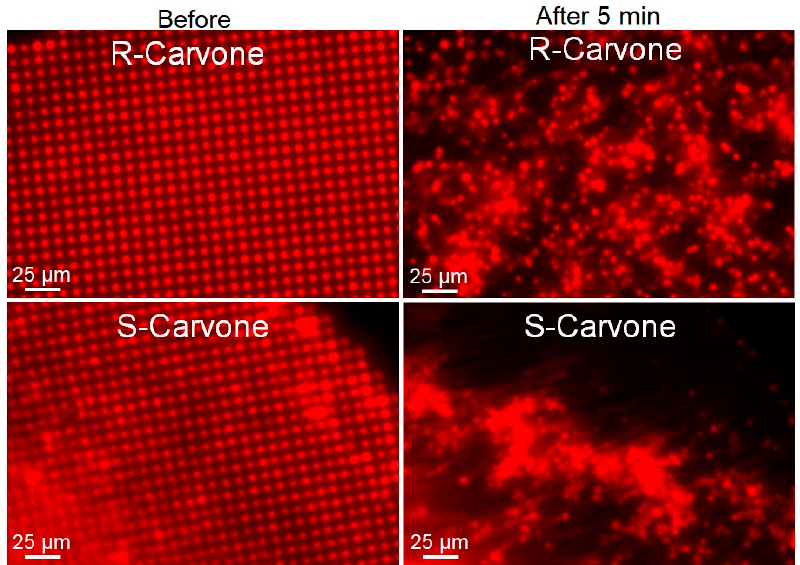
Figure 5. Lipid multilayer fluorescence assay upon exposure to R-carvone and S-carvone. Both enantiomers were found to significantly disrupt the lipid multilayer structures. Lipid dots exposed to 1 mM R-carvone demonstrated spreading and dissolution, while lipid multilayers exposed to 1 mM S-carvone tended to demonstrate more tension and remodeling effects.